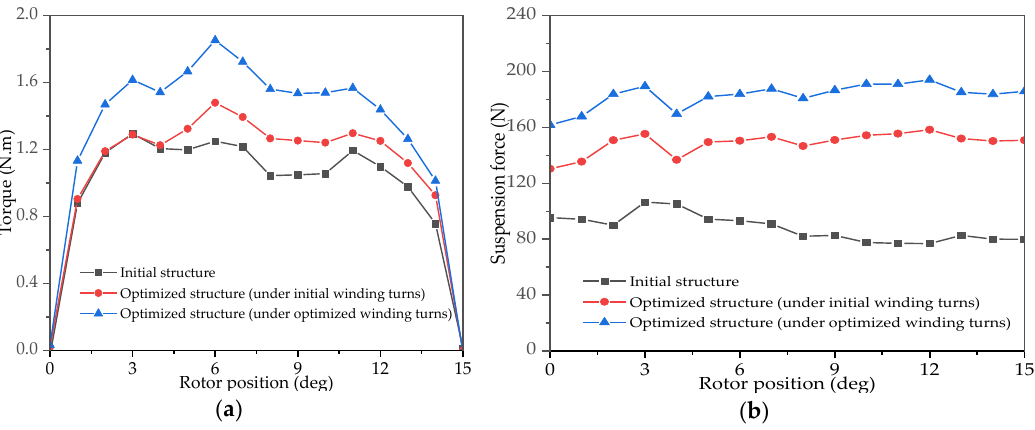
Figure 11. Cross section of machine before and after optimization: ( a ) before optimization; ( b ) after optimization.